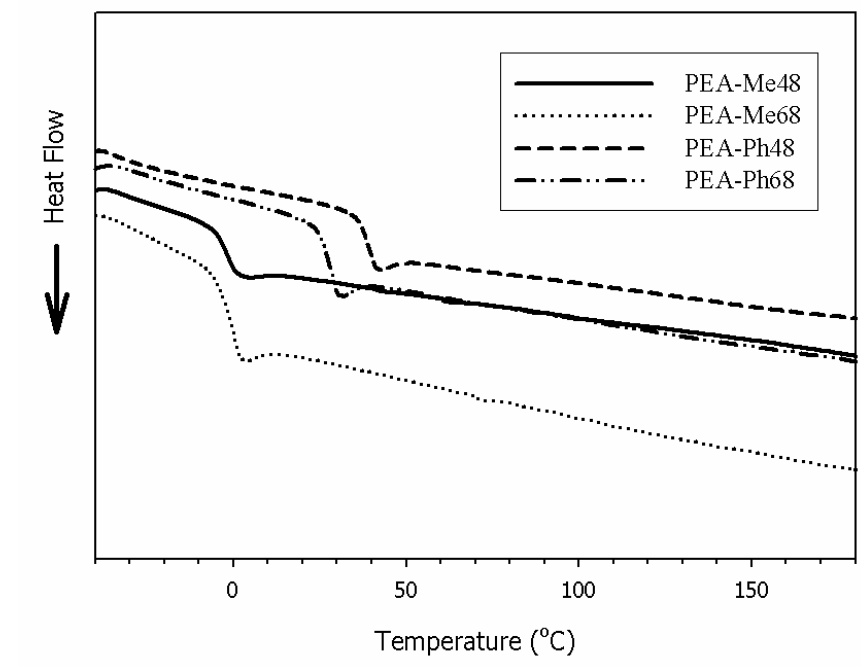
Figure 5. DSC thermograms of PEAs synthesized from the amino acids L -phenylalanine and L